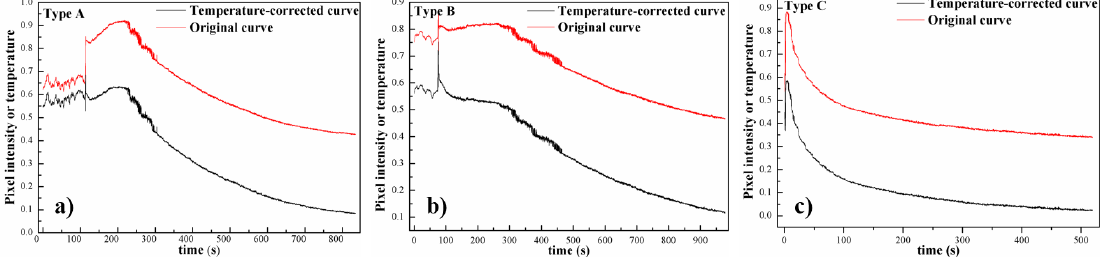
Figure 10. Three original thermal curves and their temperature-corrected curves: ( a – c ) are types A–C,